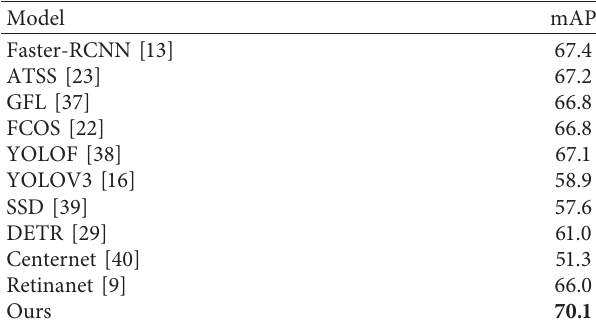
Table 2: Our proposed algorithm vs. other algorithms with ResNet-50 and FPN as default.